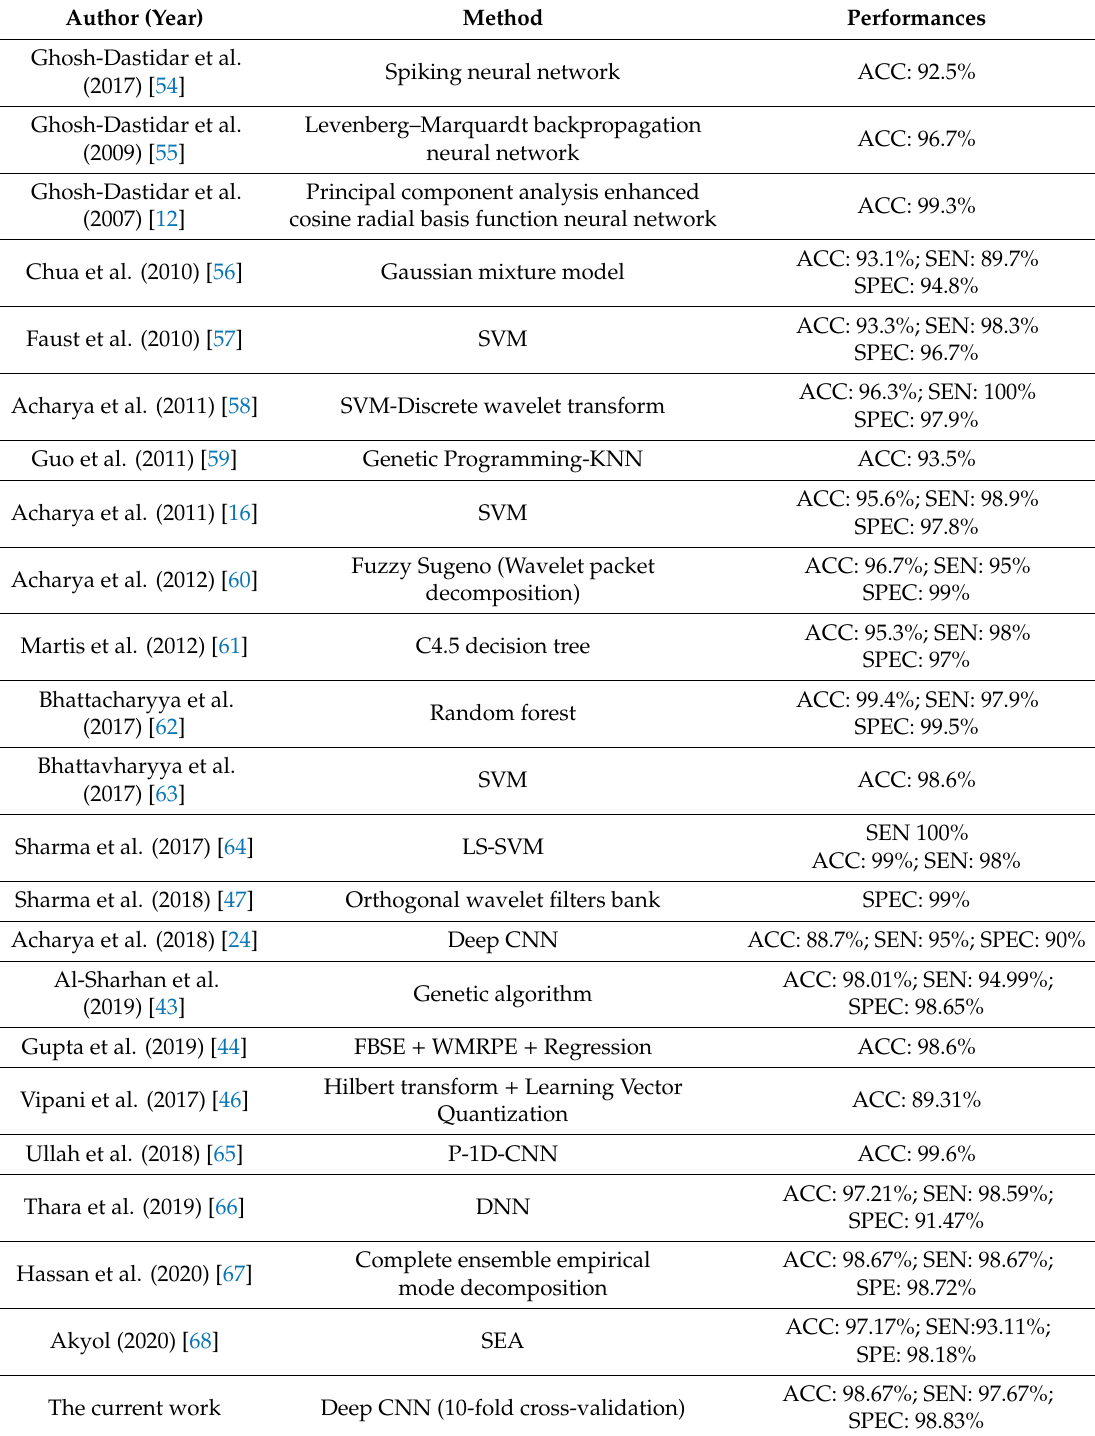
Table 5. Comparative results of di ff erent